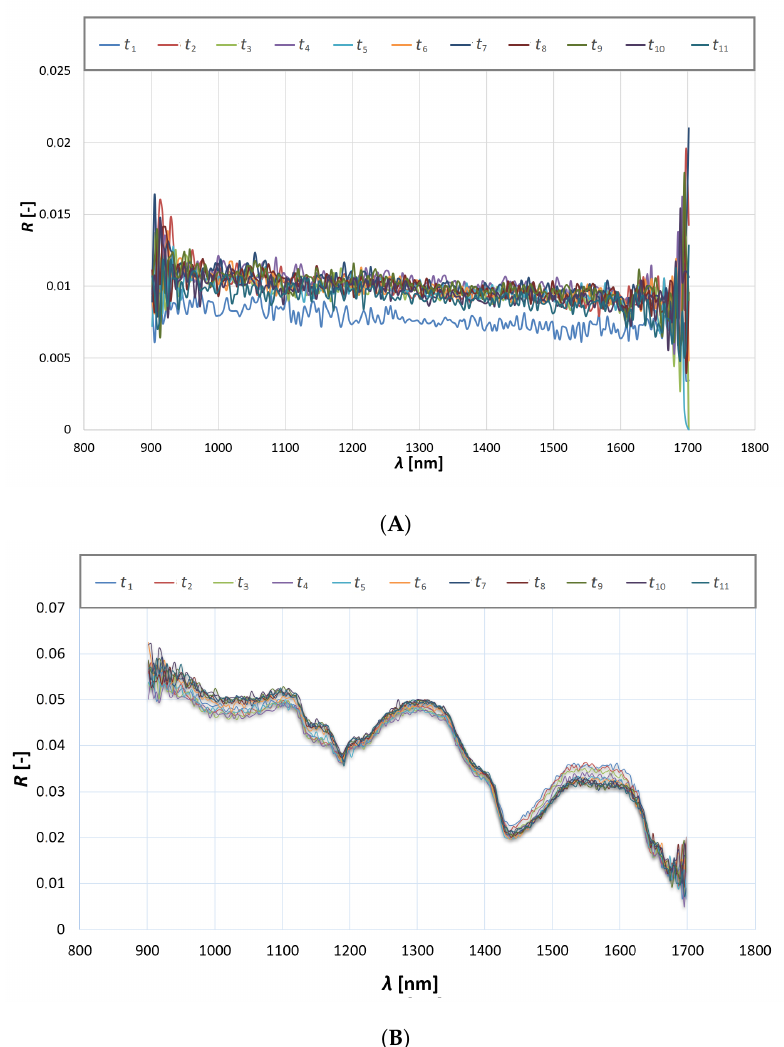
Figure 3. Reflectance spectra of two adhesive materials: ( A )—superglue, ( B )—epoxy